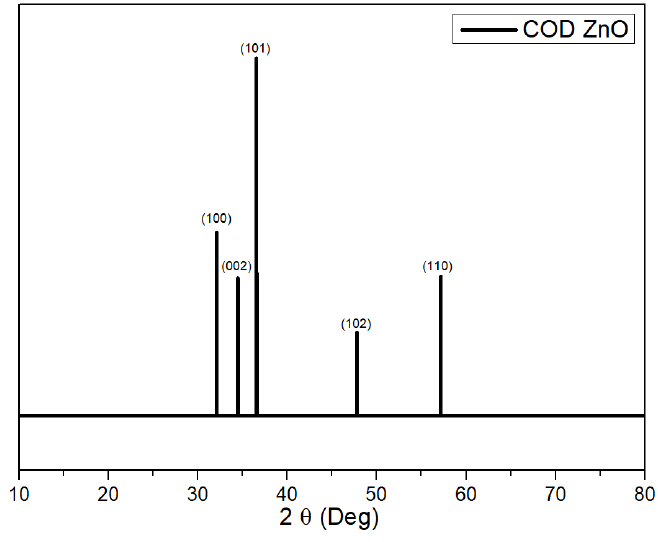
Figure 9. Crystallography of Database (COD) code 1011258. Table 3. Crystallite size and lattice parameters.